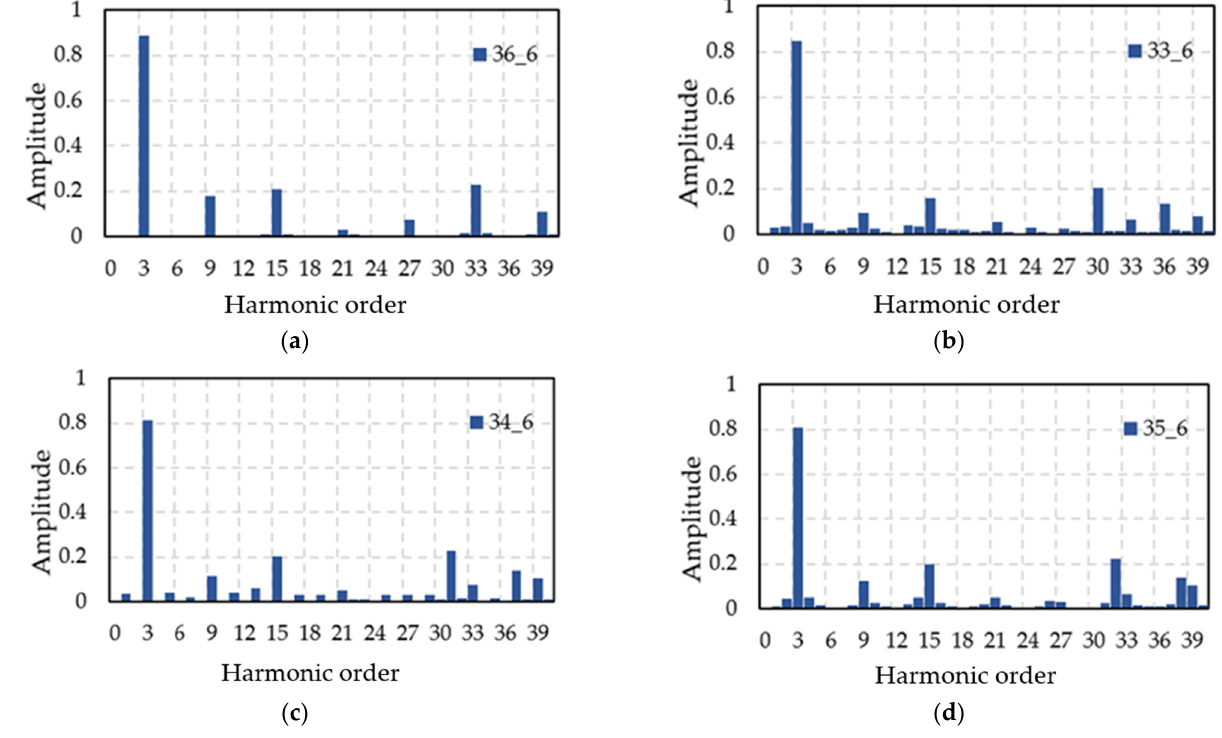
Figure 8. Air − gap flux density harmonics of four motors with two − layer flux barrier and PM: ( a ) M 1 : 36 − slot and 6 − pole; ( b ) M 2 : 33 − slot and 6 − pole; ( c ) M 3 : 34 − slot and 6 − pole; ( d ) M 4 : 35 − slot and 6 − pole.